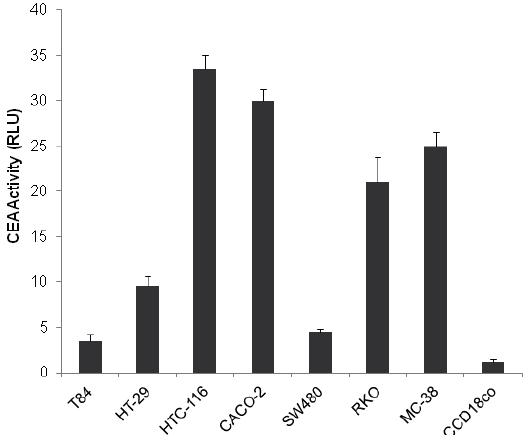
Figure 1. Transcriptional activity of CEA. Human CACO-2, HT29, HCT-116, SW480, RKO and T-84 colon adenocarcinoma cell lines, mice MC-38 colon cancer cell line, and the normal human colon CCD18co cell line Cells were co-transfected with luciferase expression vectors pPGL2/CEA or pGL2 and the Renilla expression vector CMV/Renilla. Luciferase activity of each transfection was normalized by the Renilla reading. Luciferase activity is represented by the ratio of the specific promoter over the activity of pGL2. Data represent the mean value of three replicates ± the standard error of the mean (SEM).